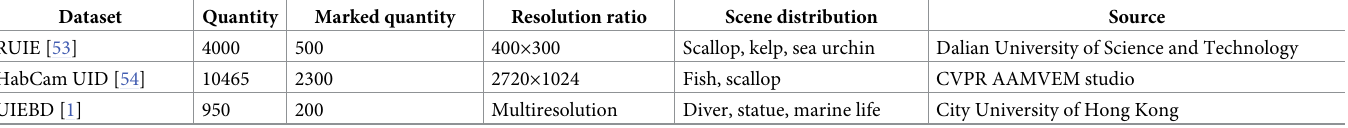
Table 2. Summary of underwater